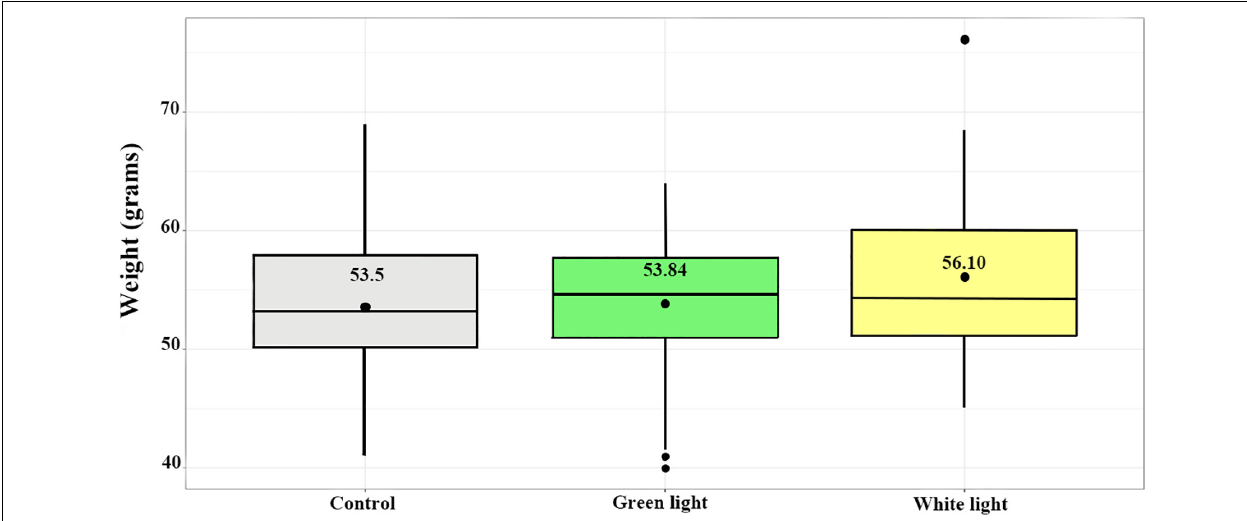
FIGURE 2 | Weights of young in the treatment groups (white and green lights) and control group. Boxes extend to upper and lower quartiles; the line indicates the median and the black point at the middle of the boxes indicates the mean. Whiskers extend to maximum and minimum values; outliers are indicated by filled